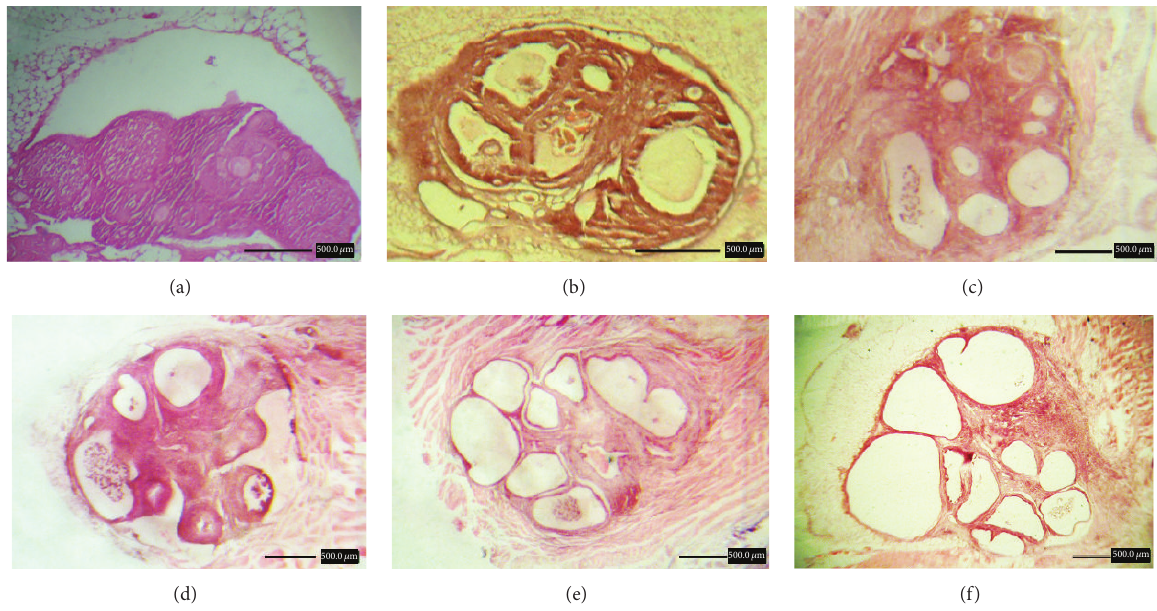
Figure 2: Comparison of the superovulatory effect of pregnant mare serum gonadotropin (PMSG) after autologous ovarian transplantation in mice. Ovaries of groups of (a) control, (b) PMSG, (c) transplantation (14d), (d) transplantation (21d), (e) PMSG/transplantation (14d), and (f) PMSG/transplantation (21d). H&E staining.